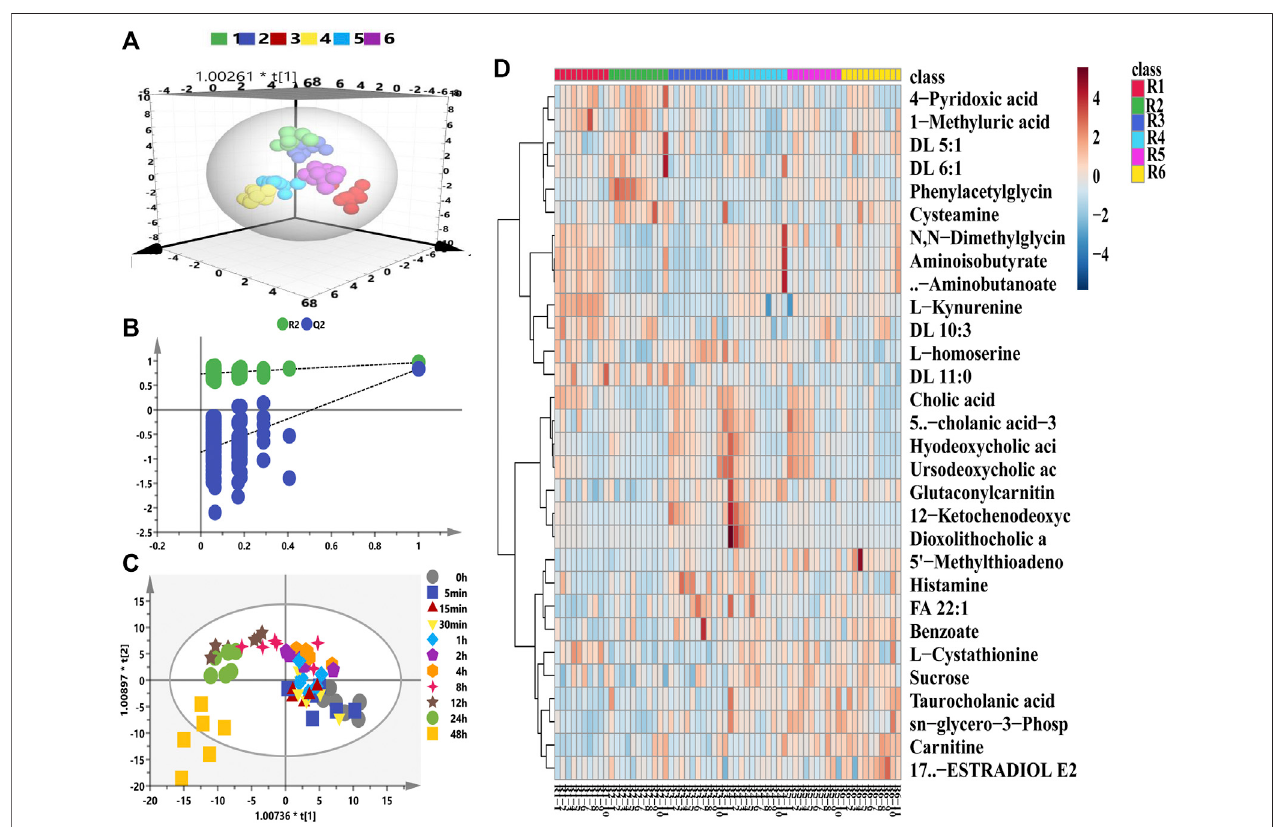
FIGURE2| Longitudinalmetabolomic fi ngerprintsofremdesivir. (A) OPLS-DAscoreplotsfromsixrats. (B) Randompermutationtestwith200iterations. (C) Time- dependent trajectory of remdesivir-treated metabolites by OPLS-DA score plots. (D) Heatmap of differential metabolites ranked in the top 30.